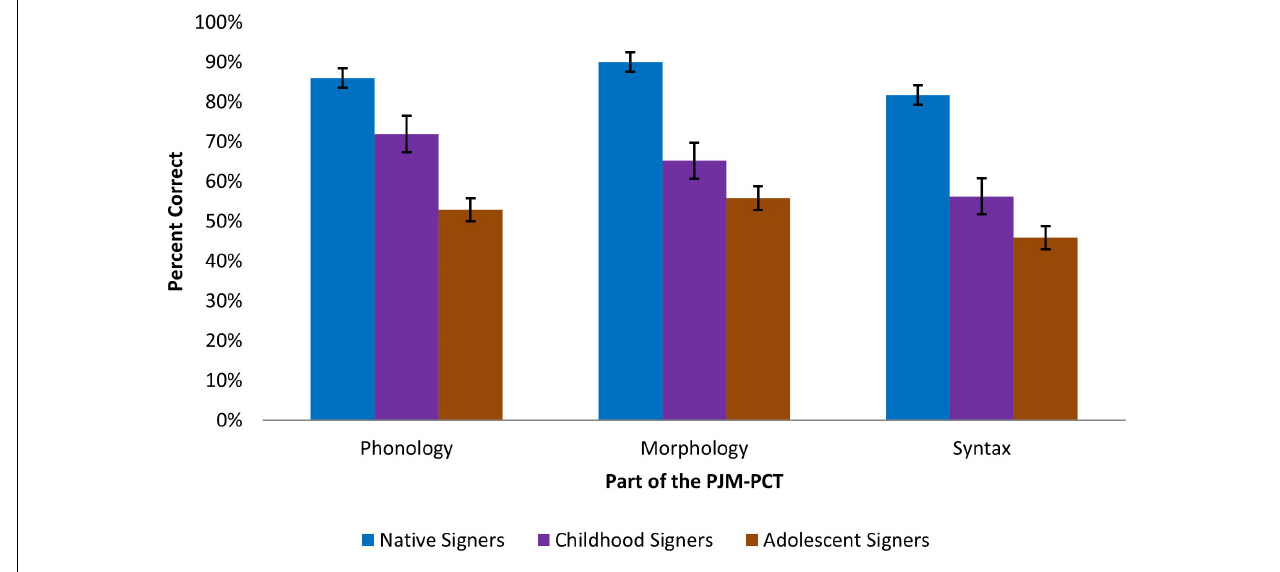
FIGURE 1 | Percent accuracy on the three sections of the PJM-PCT by age of PJM acquisition.